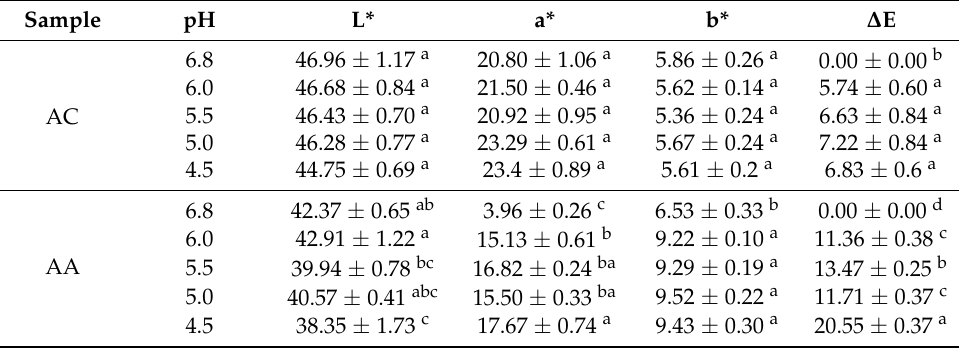
Figure 8. The color behavior of the CA ( A ) and AA ( B ) sensors under milk acidification by the addition of lactic acid (excess milk was removed for better visualization of color changes when capturing the photo). Table 5. Total color change values for the AC and AA colorimetric